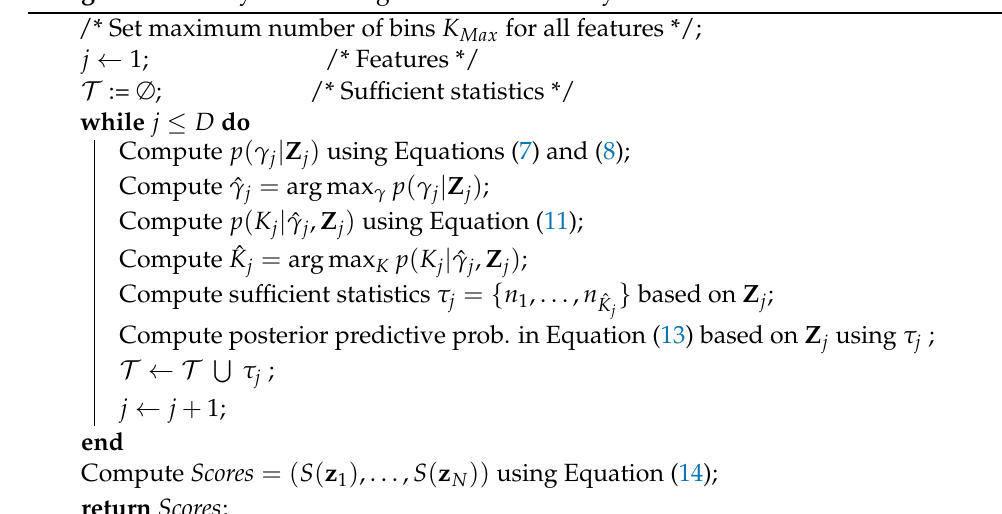
Algorithm 1: Bayesian Histogram-based Anomaly